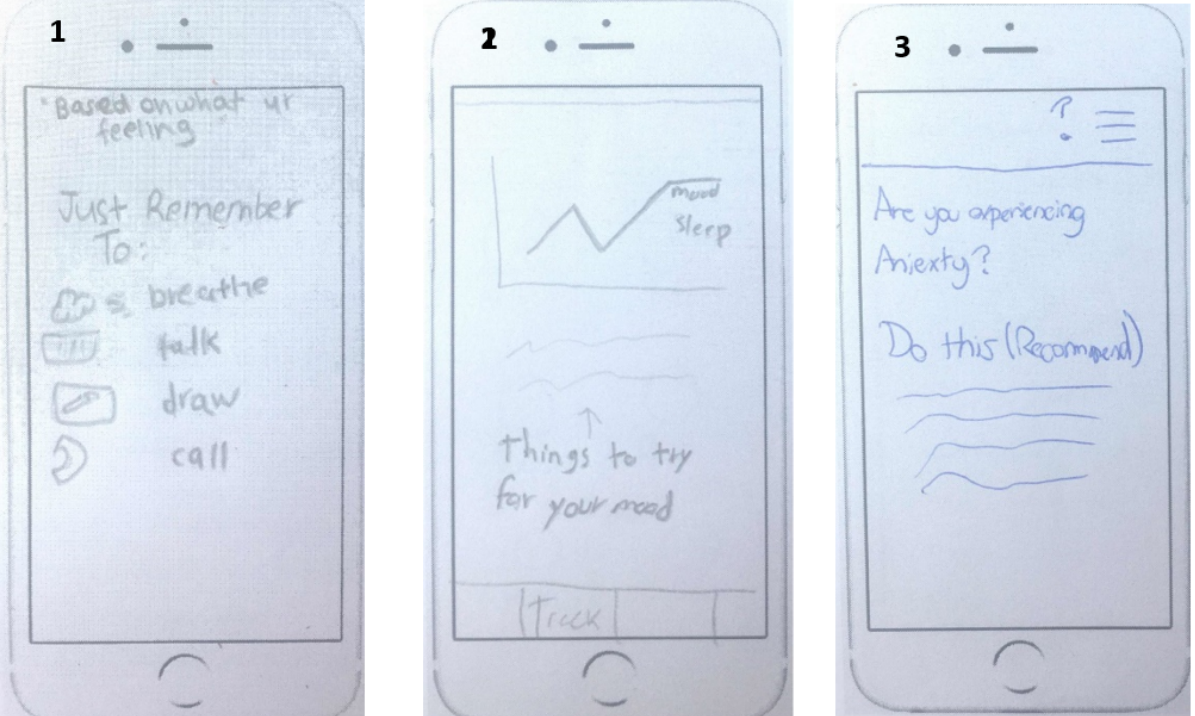
Figure 4. Three implementation ideas of a suggestion feature: (1) suggesting activities based on the moods entered, (2) providing suggestions to improve one’s mood based on collected data, and (3) providing general